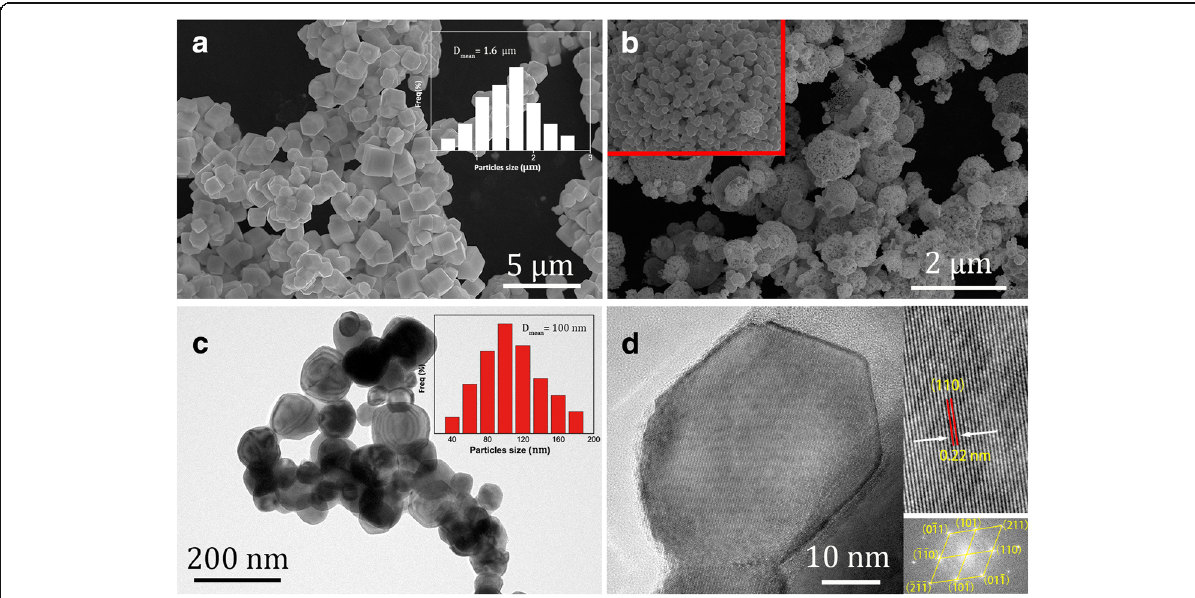
Fig. 6 Characterization of W powders. a Microstructure of W particles prepared by one-step calcination. b Microstructure of W particles prepared by two-step calcination. c TEM image of W particles with particle size distribution by two-step calcination and d HRTEM image of W particles with SAED pattern inset by two-step calcination